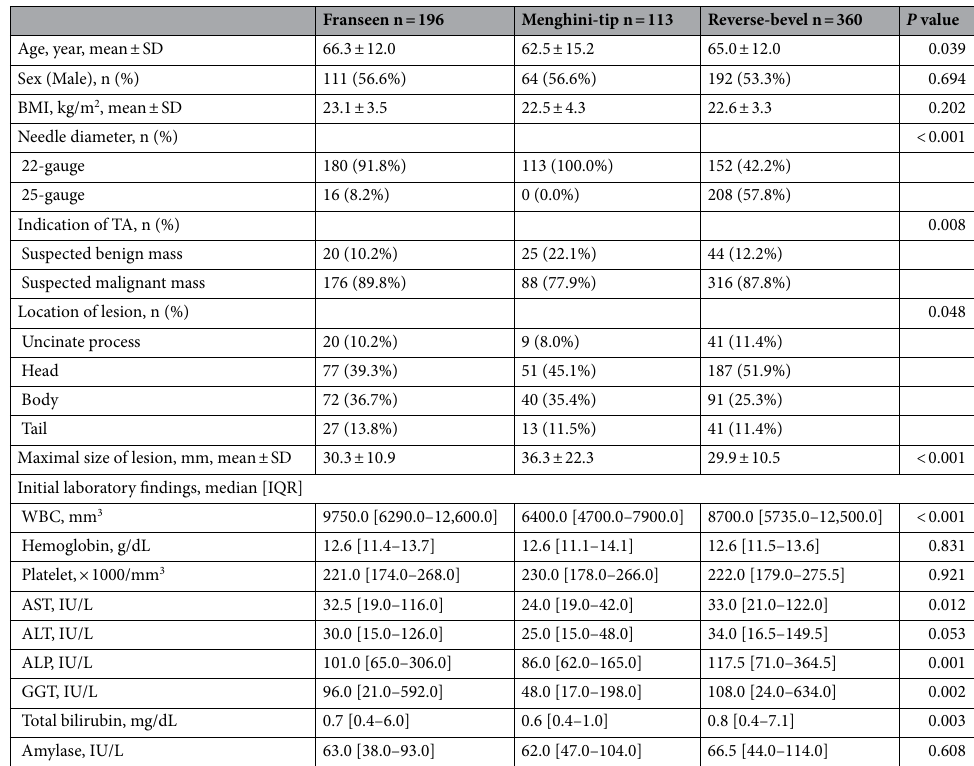
Table 1. Characteristics of patients. SD, standard deviation; BMI, body mass index; WBC, white blood cell; AST, aspartate aminotransferase; IU, international unit; ALT, alanine transaminase; ALP, alkaline phosphatase; GGT,